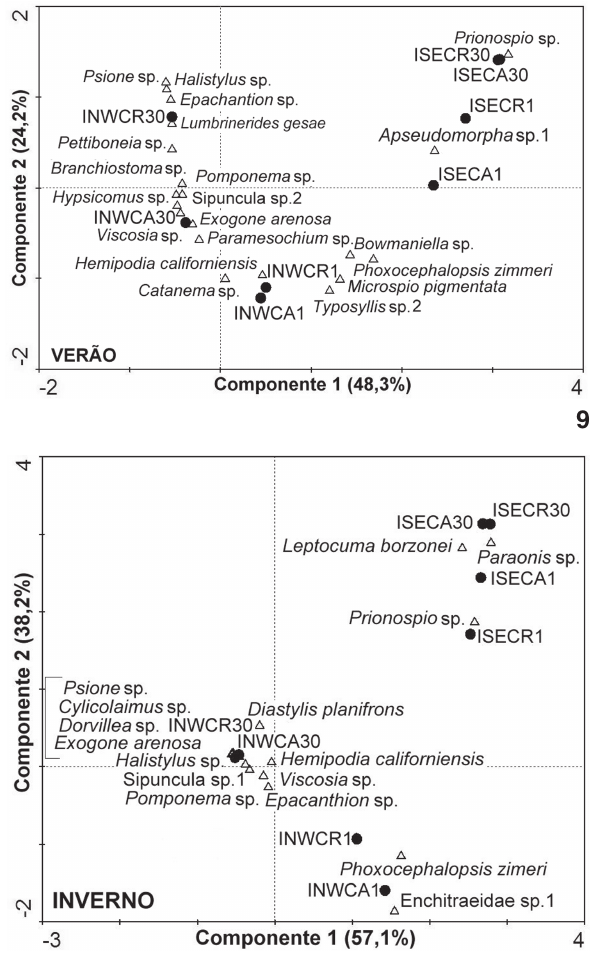
Figuras 9-10. Resultado da análise de Correspondência da infauna da laje submersa nas proximidades das ilhas Itacolomis (I) no verão (9) e no inverno (10), nas faces exposta (SE) e protegida (NW); nas cristas (CR) e cavas (CA); nos distanciamentos de 1 e 30 m.